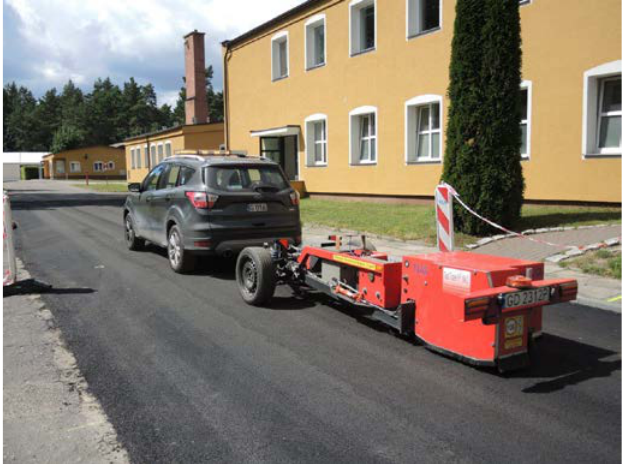
Figure 25. Test trailer R 2 Mk.2 during measurements of rolling resistance on the Dąbrówka test section.